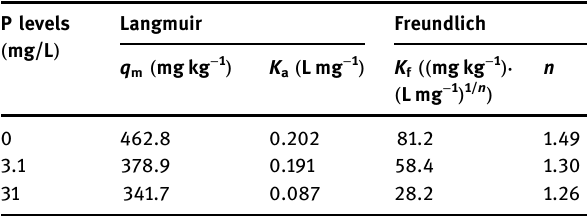
Table 2: Langmuir and Freundlich isotherm constants for molybdate ion sorption by the acidic yellow - brown soil at three P addition levels P levels ( mg/L )